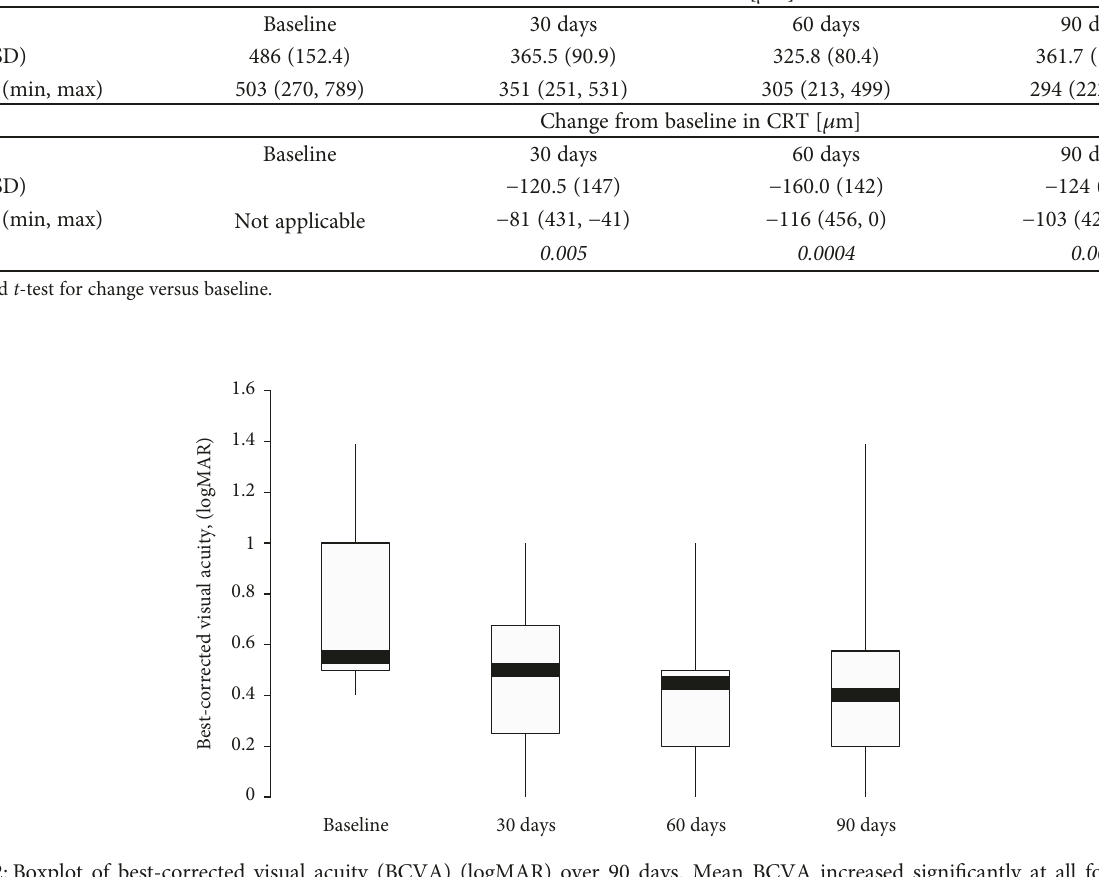
Figure 2: Boxplot of best-corrected visual acuity (BCVA) (logMAR) over 90 days. Mean BCVA increased signi fi cantly at all follow-up ( p ≤ 007 ), mainly at 60 days after